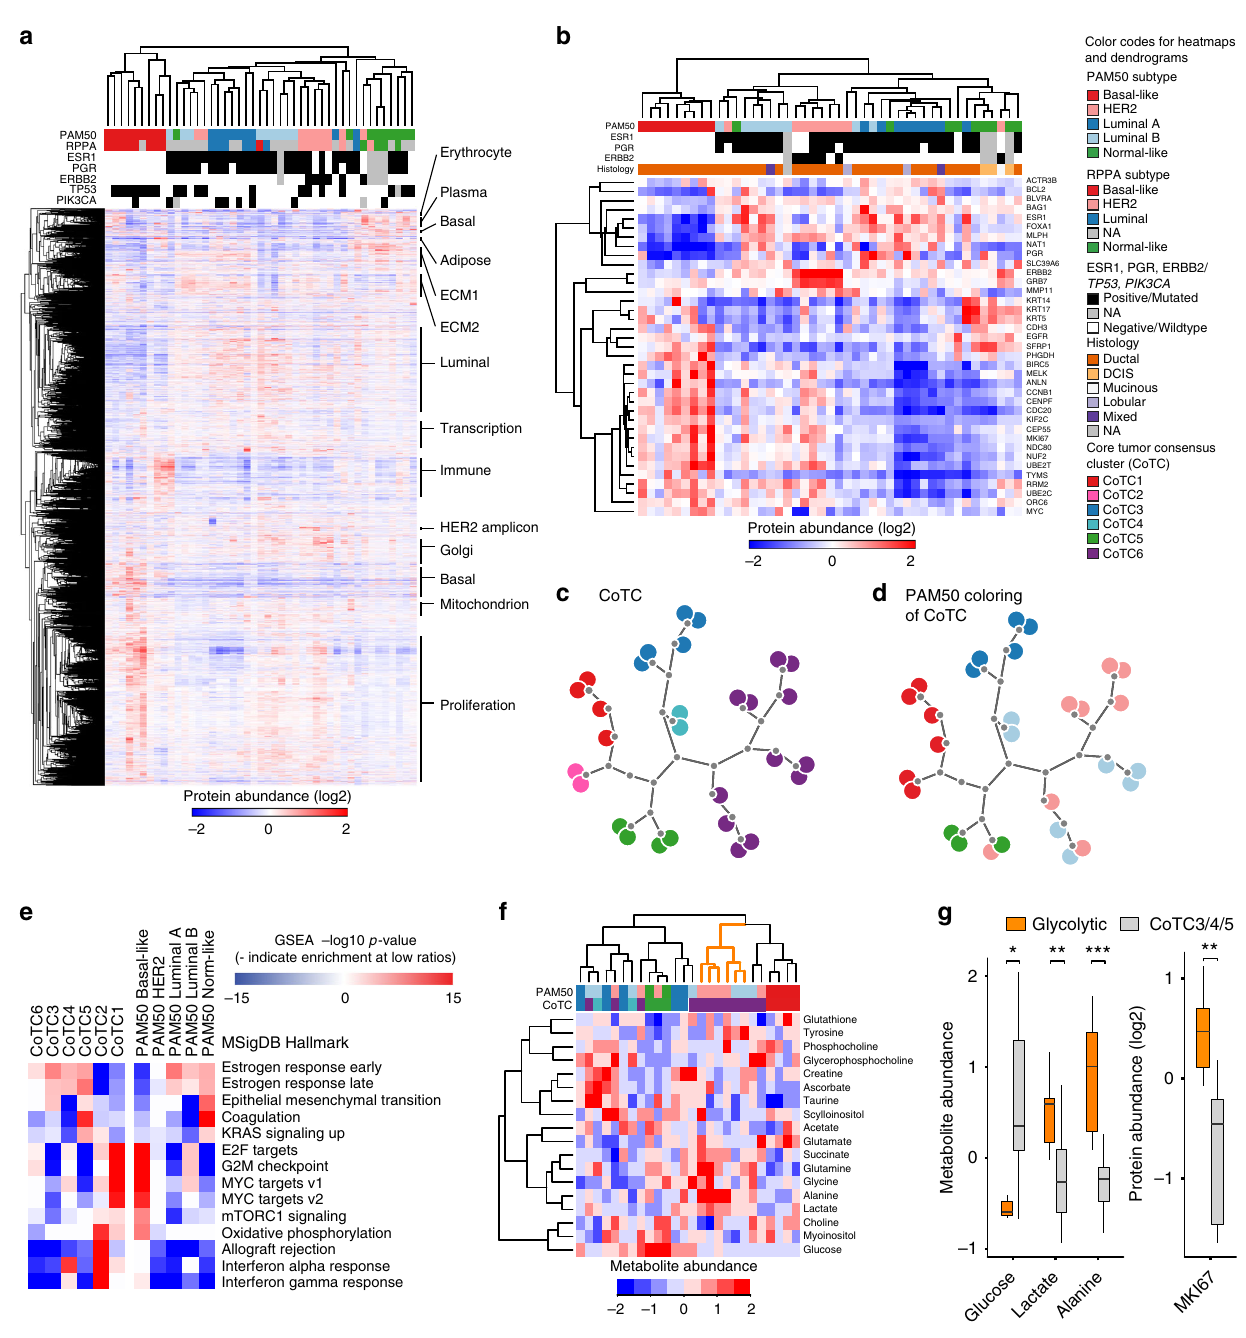
Fig. 2 Proteome clustering, relation to PAM50 subtypes and metabolites. a Proteome-driven clustering of proteins mapping to 9995 gene symbols with overlapping quanti fi cation in all 45 tumors. Protein cluster characteristics, by GO enrichment analysis, are highlighted to the right (see Supplementary Fig. 2 for details). b Clustering of identi fi ed and quanti fi ed proteins from the PAM50 panel ( n = 37). c Dendrogram visualization of core tumor consensus clusters (CoTC) into six clusters. For details, see Supplementary Methods and Supplementary Fig. 4. d PAM50 subtype assignments for the CoTCs in c . e Ranked gene set enrichment analysis (GSEA) of CoTC and PAM50 subtypes. f Clustering of HR-MAS measured metabolite levels and relation to CoTCs and PAM50 subtypes. Tumors with glycolytic characteristics are indicated in orange. HR-MAS data are not available for CoTC2 tumors. g Levels of glucose and its conversion product lactate and alanine, as well as MKI67 protein abundance in glycolytic tumors compared to other luminal tumors. T-test, * p < 0.05, ** p < 0.01, *** p < 0.001. In box plots, center line represents median and the boxed region represents the fi rst to third quartile, whiskers